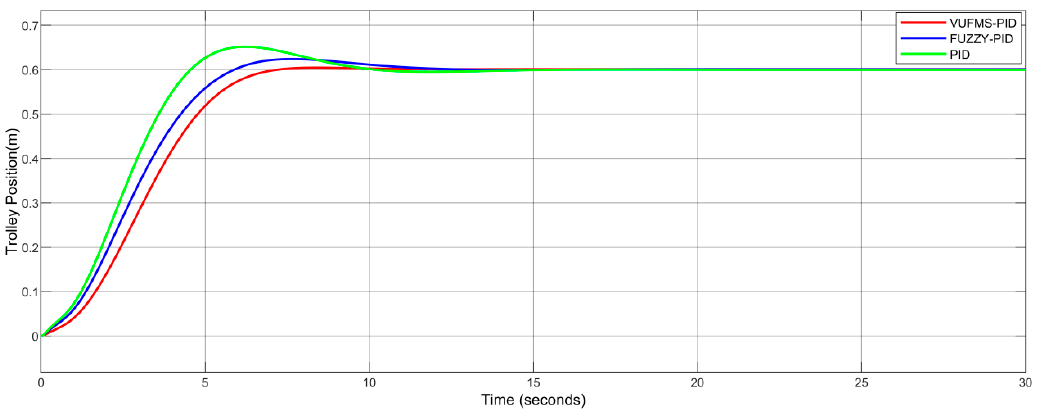
Figure 10. Trolley’s position using VUFMS-PID, FUZZY-PID and PID controller under working condition 2.